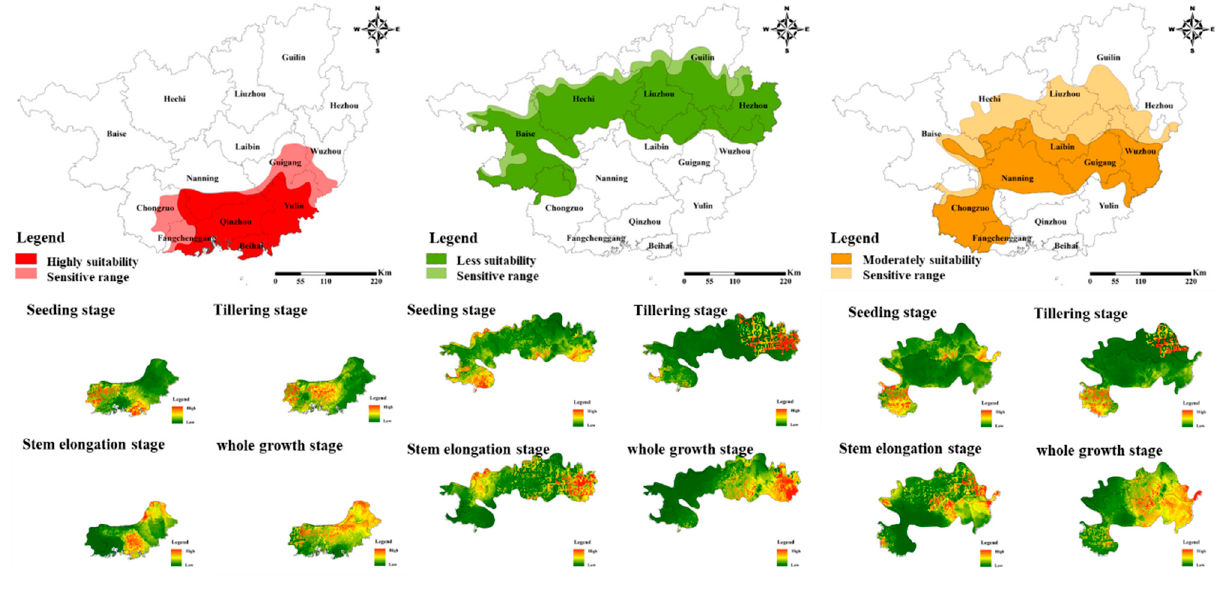
Figure 14. Spatial changes in the potential exposure range of sugarcane in the four growth stages (seedling, emergence, tillering, stem elongation, and maturity) in the two periods (1960–1989 and 1990–2019).